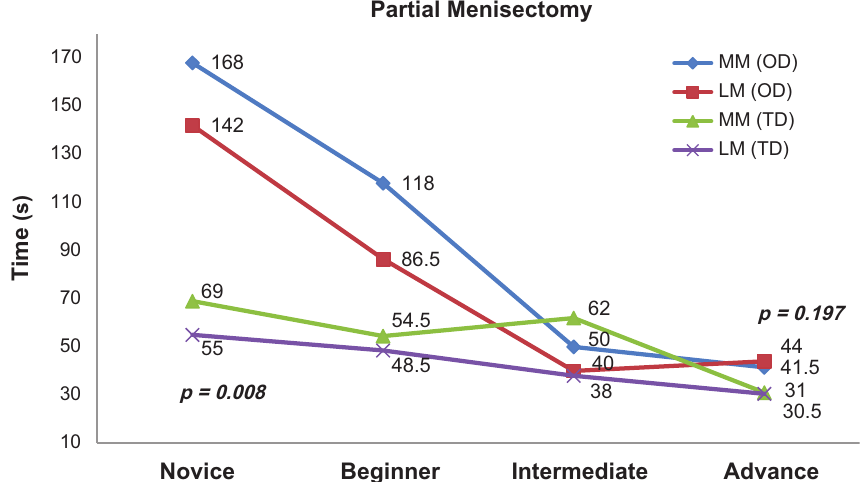
Figure 4. Individual times (s) for medial meniscus (MM) and lateral meniscus (LL) taken by groups under transparent dome (TD) and opaque dome